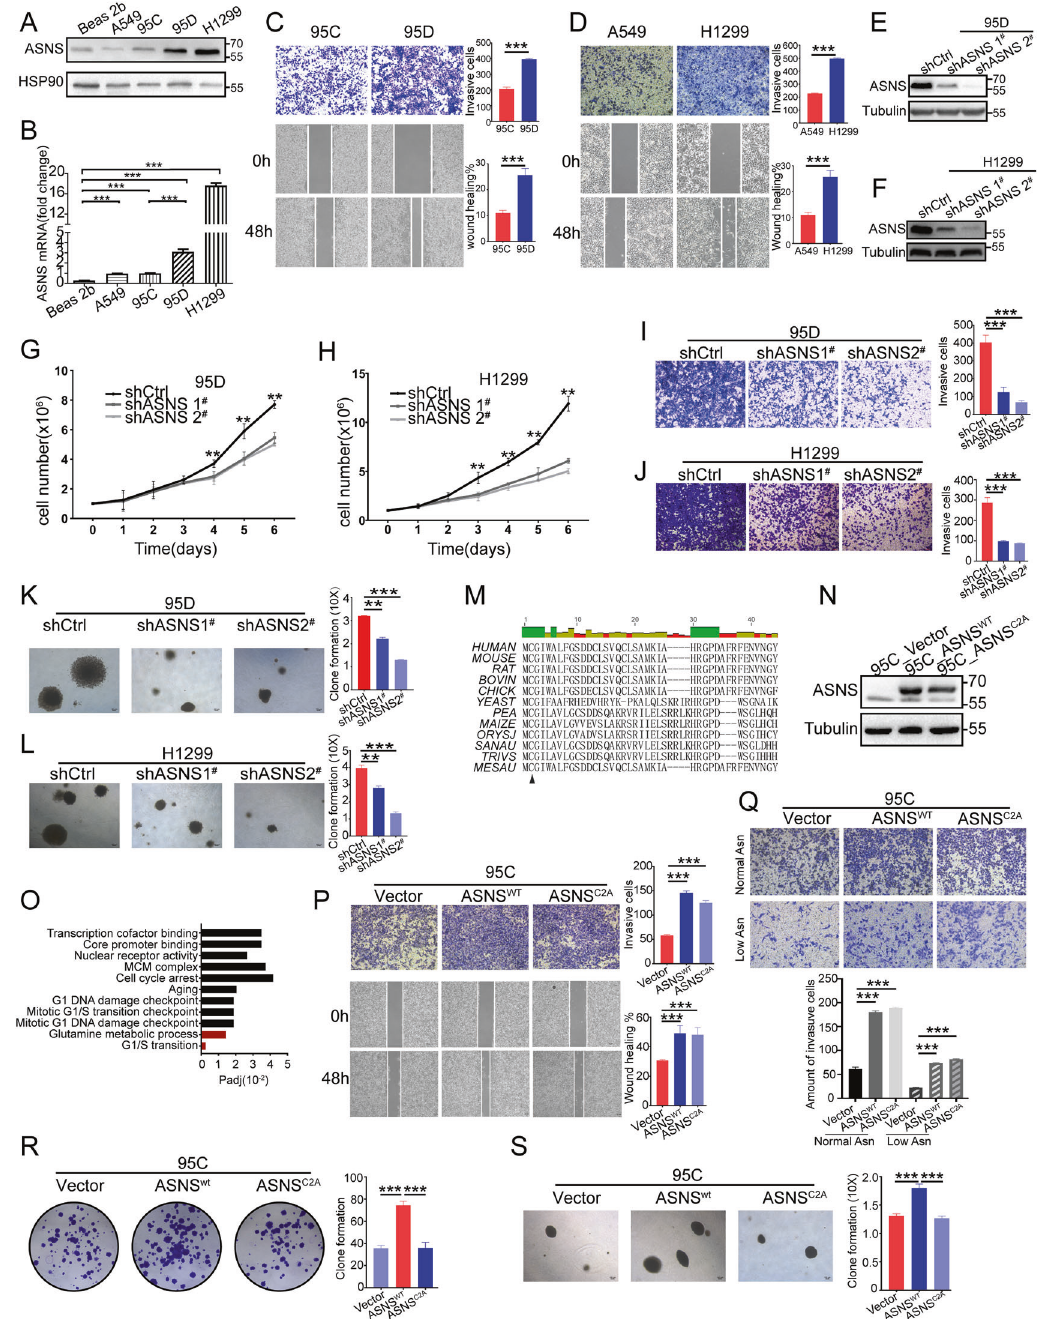
Fig. 2 ASNS enhances cellular invasiveness independent of endogenous asparagine products. In different lung-cancer cell lines, ASNS were tested in protein ( A ) and mRNA ( B ) levels, ASNS mRNA level was analyzed by Student ’ s t test. 95C and 95D cell lines were derived from the same lung-cancer patient and domesticated into high metastasis (95D) and low metastasis (95C) cell lines ( C ); H1299 and A549 cell lines were also paired cell lines, their invasive and migrative ability were tested ( D ), Student ’ s t test was used for statistic test. ASNS protein was knocked down in 95D and H1299 ( E , F ), cell growth number was recorded ( G , H ), and the different growth speeds were tested by Student ’ s t test. Knockdown-ASNS cells were seeded into Matrigel-coated Transwell chambers and cultured in FBS gradient medium for 36 h. The count of invasive cells was recorded in 95D group ( I ) and H1299 group ( J ), the different invasive abilities were tested by Student ’ s t test. At the same time, knockdown-ASNS cells were seeded into colony assay ( K , L ), then cultured for 2 – 3 weeks. M aligning ASNS protein sequence in different species. And building ASNS WT and ASNS C2A cell lines ( N ). ASNS C2A cells defected glutamine metabolism and asparagine synthesis according to RNA sequencing data ( O ). The ASNS overexpressed cells were seeded into invasive and migrative assay in normal asparagine medium ( P ) and low asparagine medium ( Q ). At the same time, these cells were seeded into crystal violet staining assay ( R ) and colony formation assay ( S ), then cultured for 2 – 3 weeks. The clone formations were analyzed by Student ’ s t test. Error bars were expressed as mean ± S.D. P < 0.05 is signi fi cant statistic difference, * p < 0.05, ** p < 0.01, *** p < 0.001. Representative images from three independent experiments are